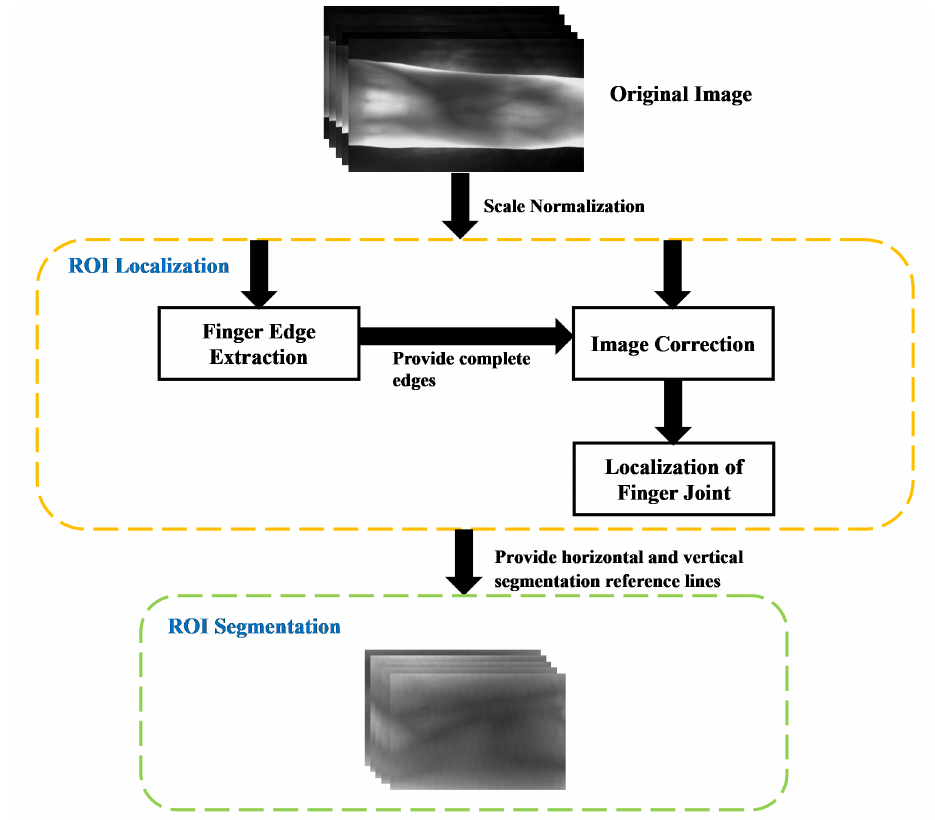
Figure 1. Block diagram illustration of the proposed